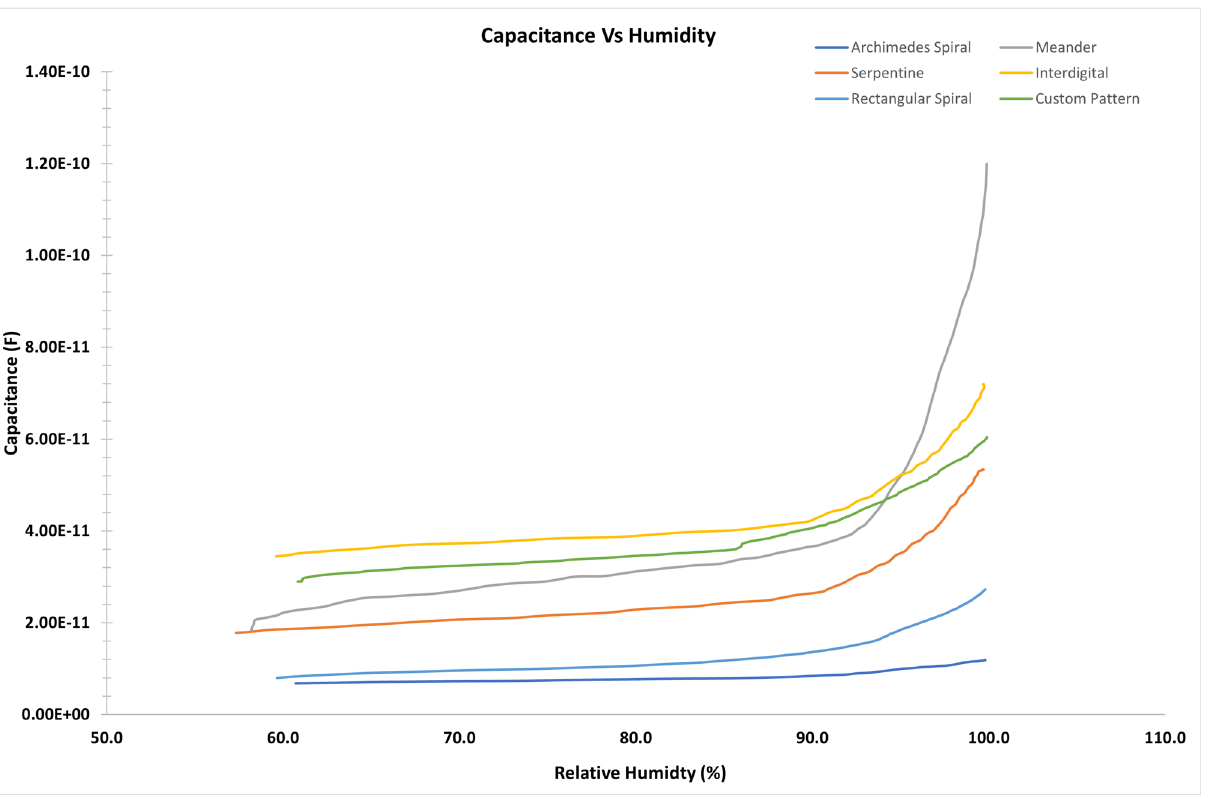
Figure 5. Humidity response of patterned sensors for ( a ) Archemedies spiral, ( b ) Meander, ( c ) Serpentine, ( d ) Interdigital, ( e ) Rectangular spiral, and ( f ) Custom design.